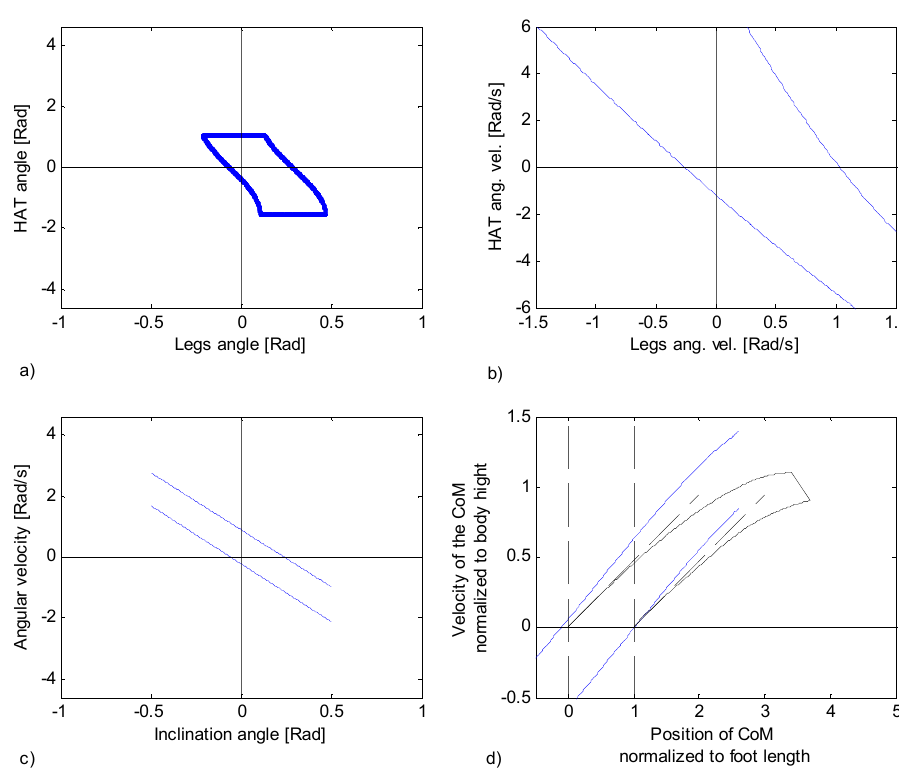
Figure 5. Some aspects of the balanceable region in the 4-dimensional state space: the part with zero Legs and HAT angular velocity (a), with zero angles (b), with equal angles and equal angular velocities (c). d) Figure (c) mapped into the (cid:2208) -plane (blue curves) and the balanceable region obtained in [5] (solid black) and in [8] (dashed black).